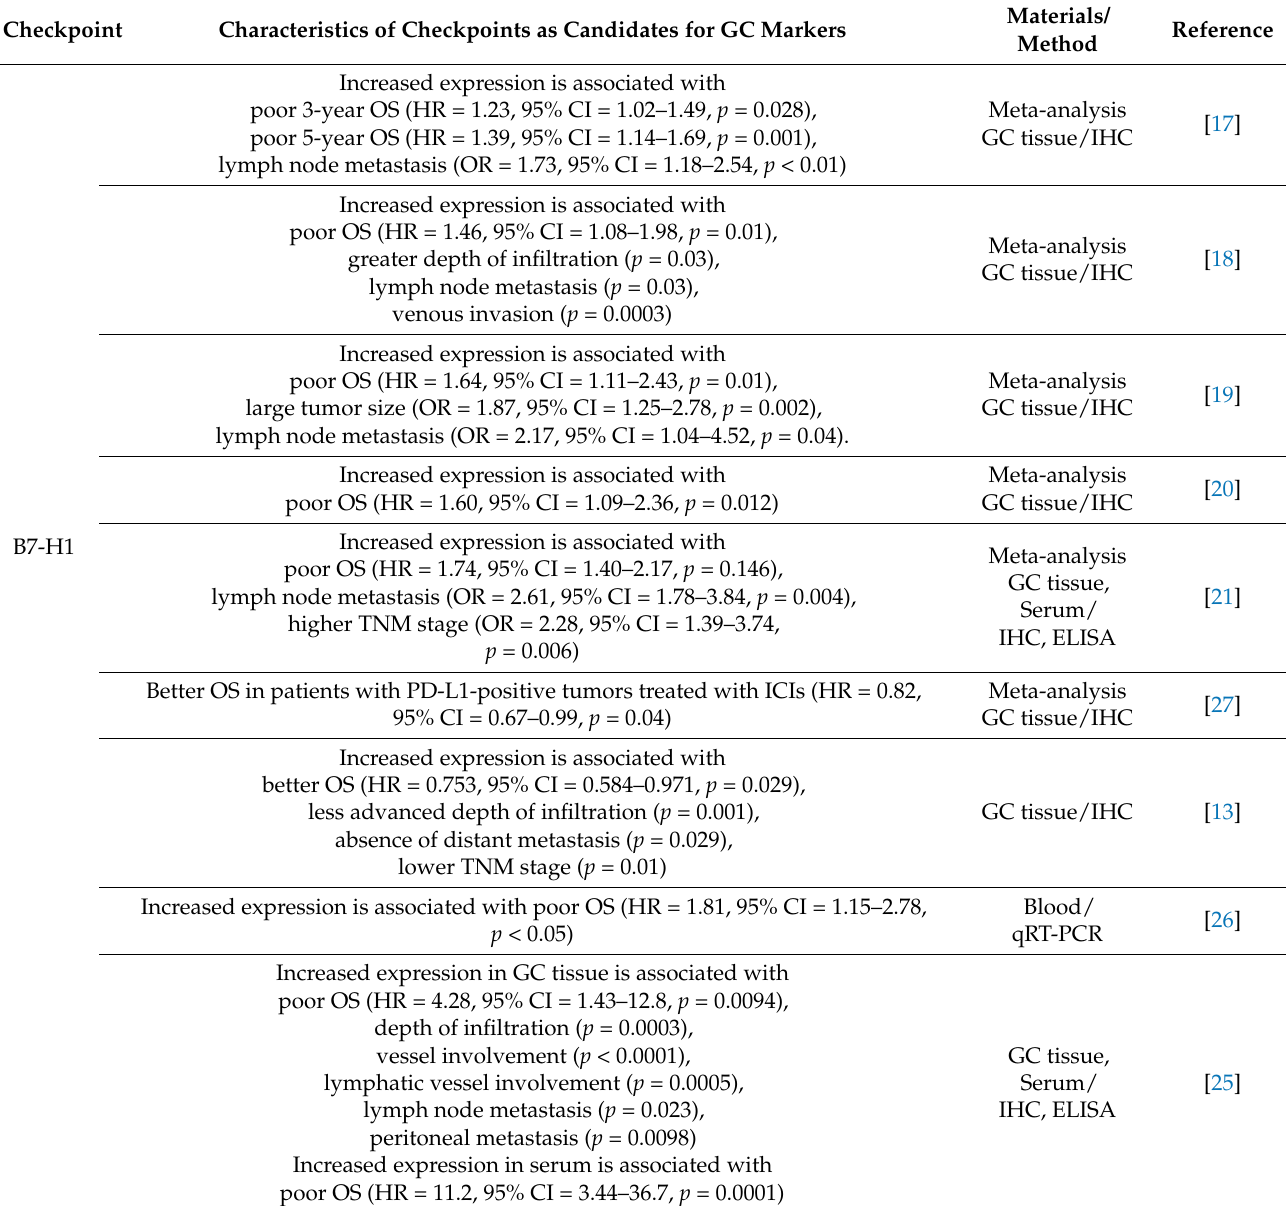
Table 2. Immune checkpoints as potential GC